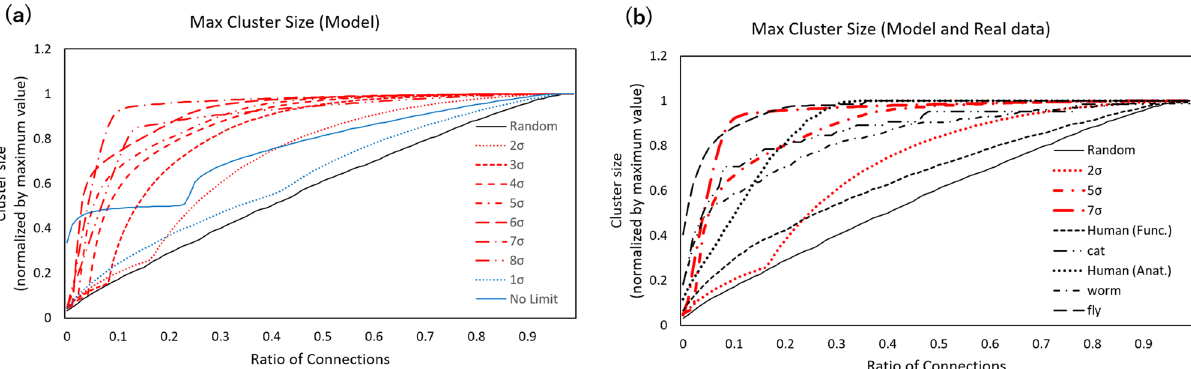
Figure 3. Network cluster size. ( a ) Model. The maximum cluster size of the network was estimated from the same data sets and is shown in the same conditions and style as in Fig. 2a. Subnetworks with strong connections were selected, and the cluster size was estimated for each network. The estimated values were normalized by the value of the initial network. The horizontal axis indicates the ratio of the connection numbers at intervals of 0.01 with which the strong connections were selected according to their values. ( b ) Model and connectomes. The connectomes were compared in the same conditions and style as in Fig.